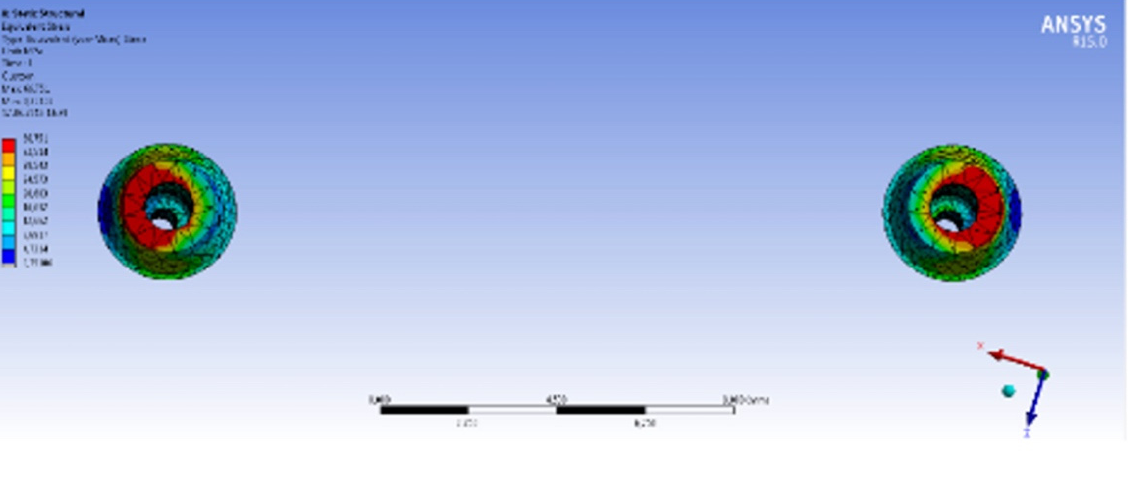
Figure 8. Model 2 multi-unit abutment and the Von Mises stress distribution from occlusal view after oblique loading.